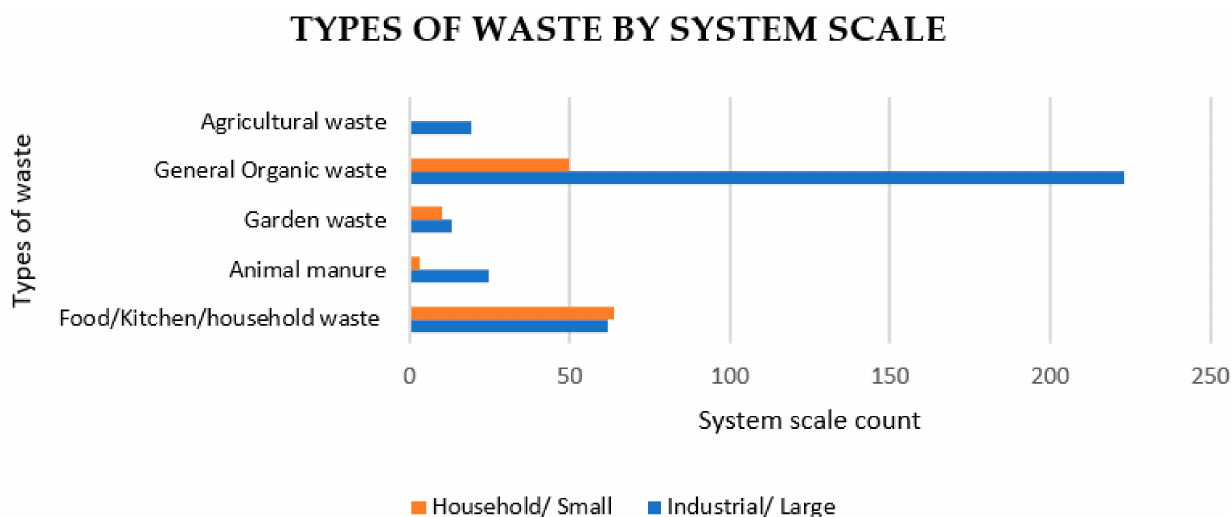
Figure 10. Waste types by system size.